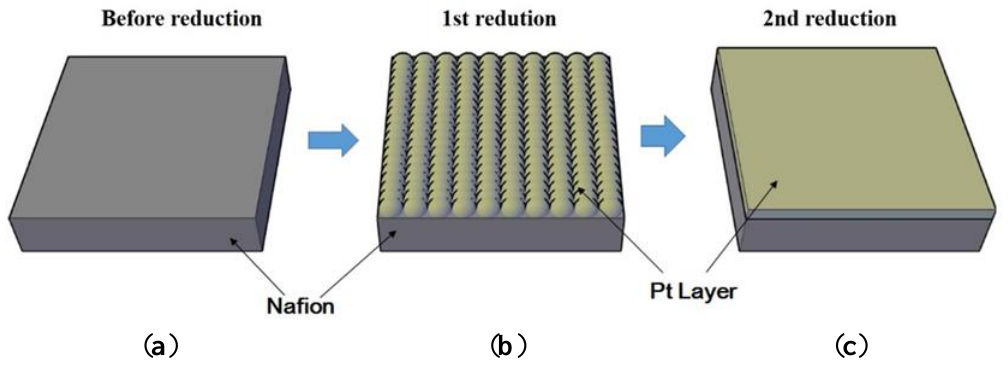
Figure 2. IPMC fabrication process. ( a ) Step 1: surface treatment; ( b ) Step 2: first plating and ( c ) Step 3: second